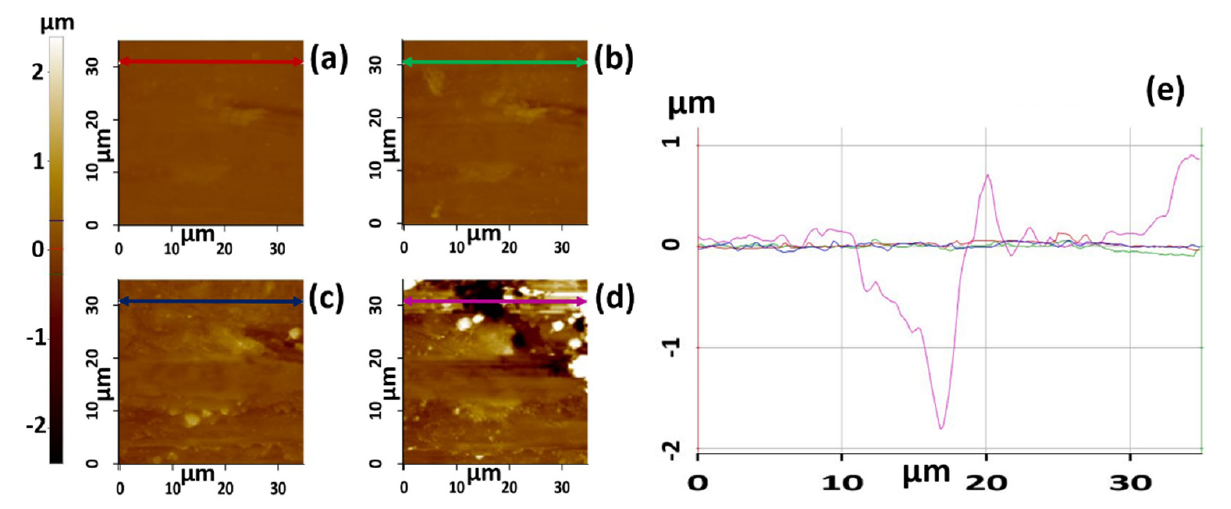
Figure 9. Surface topography of bare aluminum alloy at ( a ) initial state, ( b ) after 1 min of accelerated corrosion, ( c ) after 2 min of accelerated corrosion, ( d ) after 3 min of accelerated corrosion, ( e ) Z–height line analysis .